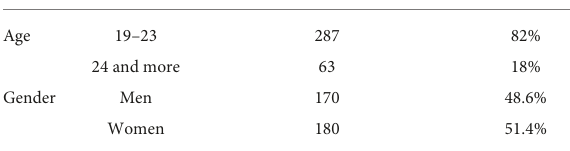
TABLE 1 Demographic information for the